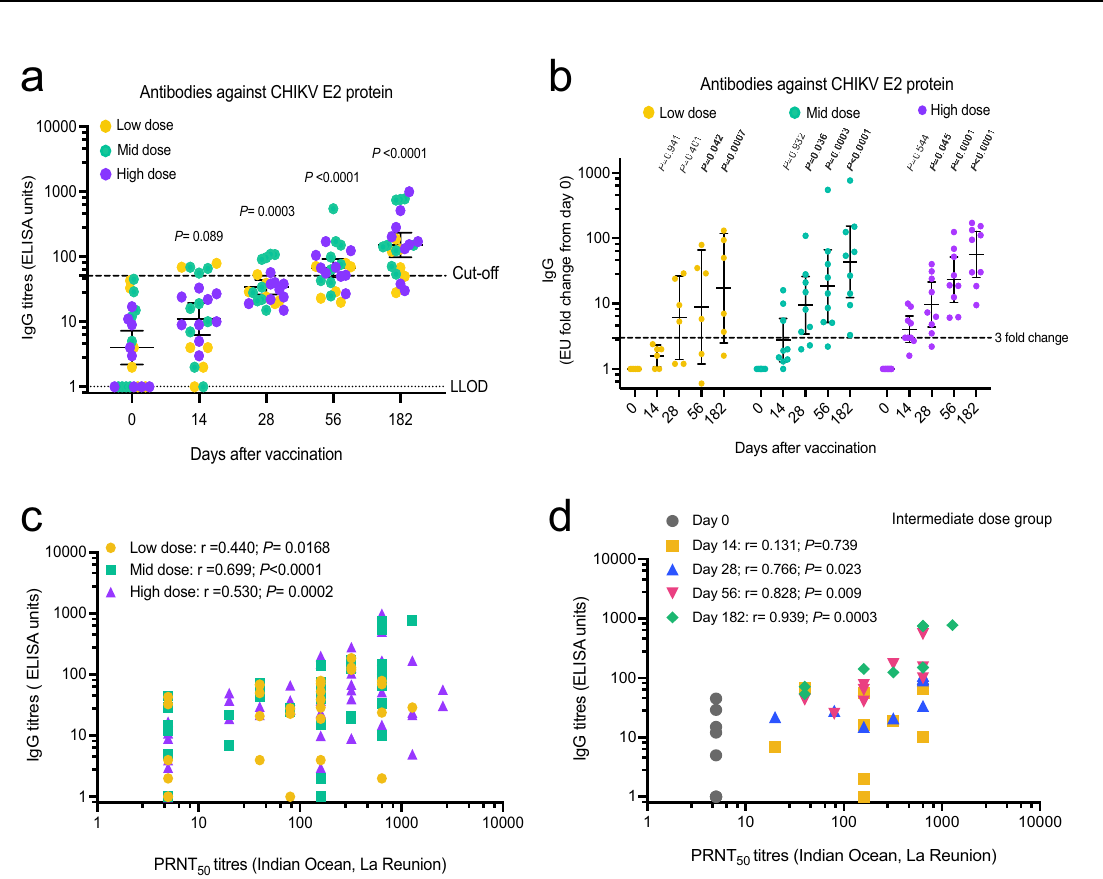
Fig. 3 ELISA titers over time. CHIKV IgG response by standardized ELISA to E2 protein in 120 serum samples of trial participants. a Individual IgG titers over time ( n = 24). The dashed line represents the cut-off value for seropositivity. Geometric means and 95% CI; Friedman test with Dunn ’ s correction. b Same data as ( a ) but represented as fold change from baseline (day 0) and analyzed by dosage group: low dose was 5 × 10 9 vp ( n = 6), intermediate (mid) dose was 2.5 × 10 10 vp ( n = 9), and high dose was 5 × 10 10 vp ( n = 9). Geometric means and 95% CI; Friedman test with Dunn ’ s correction. c Correlation of PRNT 50 and IgG ELISA by dosage group at 5 time points. Low dose, six participants, n = 29 (on day 56, samples were excluded due to QC failure); intermediate (mid) dose, nine participants ( n = 45); high dose, nine participants ( n = 45). Spearman correlation, two-tailed. d Same data as ( c ) but correlation is only shown for the nine participants vaccinated at the intermediate (mid) dose ( n = 9 per timepoint). Spearman correlation, signs and symptoms for seven days following vaccination; (b) occurrence of solicited systemic reactogenicity signs and symptoms for seven days following vaccination; (c) occurrence of unsolicited adverse events (AEs) for 28 days following vaccination; (d) change from baseline for safety laboratory measures; (e) occurrence of serious adverse events (SAEs) during the whole study duration. The secondary objective was to assess CHIKV structural antigen-speci fi c humoral and cellular immune responses induced by ChAdOx1 Chik as measured by enzyme- linked immunosorbent assay (ELISA), plaque reduction neutralization test (PRNT) and ex vivo interferon-gamma (IFN- γ ) enzyme-linked immunospot (ELISpot). Eligible volunteers were recruited at the Centre for Clinical Vaccinology and Tropical Medicine, Oxford, United Kingdom (CONSORT diagram, Fig. 1). All